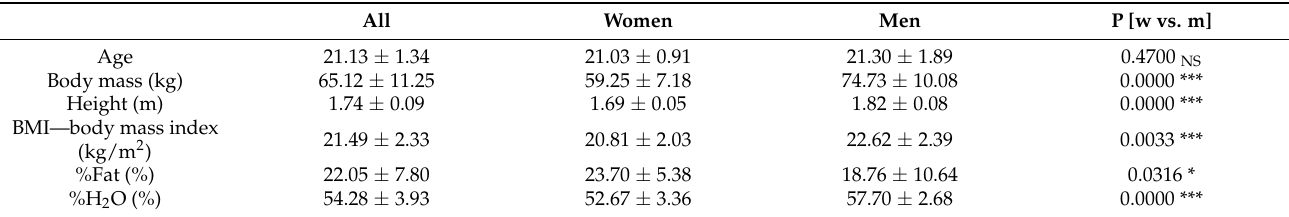
Table 1. Anthropometric